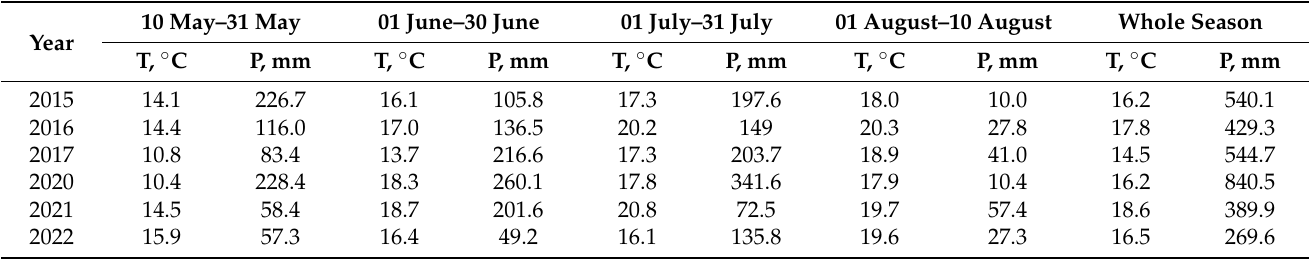
Figure 1. Daily air temperature (minimum and maximum) and precipitation during field seasons when plants were grown. Table 1. Average air temperature (T, °C) and sum of precipitation (P, mm) in different periods of plant growth.